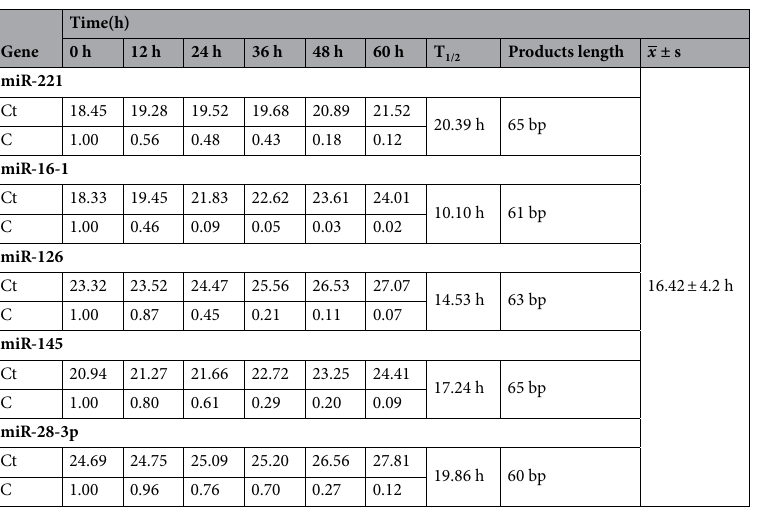
Table 8. Changes in miRNAs concentration in whole blood at room temperature. The 95% confidence interval for T 1/2 was calculated to be (12.739,